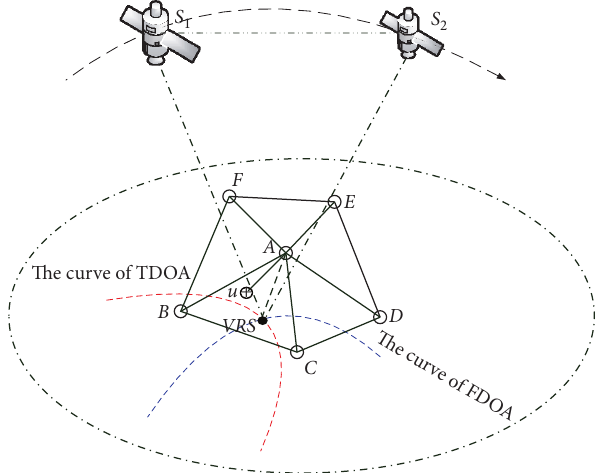
Figure 1: Considered system model with six reference stations in the coverage of LEO